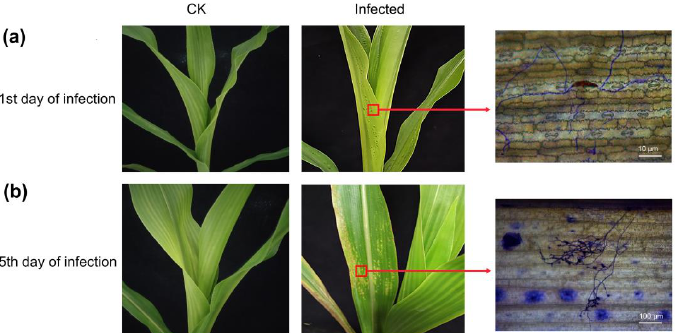
Figure 1. The phenotype of maize leaves after Bipolaris maydis infection on ( a ) day 1 and ( b ) day 5. The insets indicated by arrows show the corresponding conidia and mycelium growth observed under the microscope.